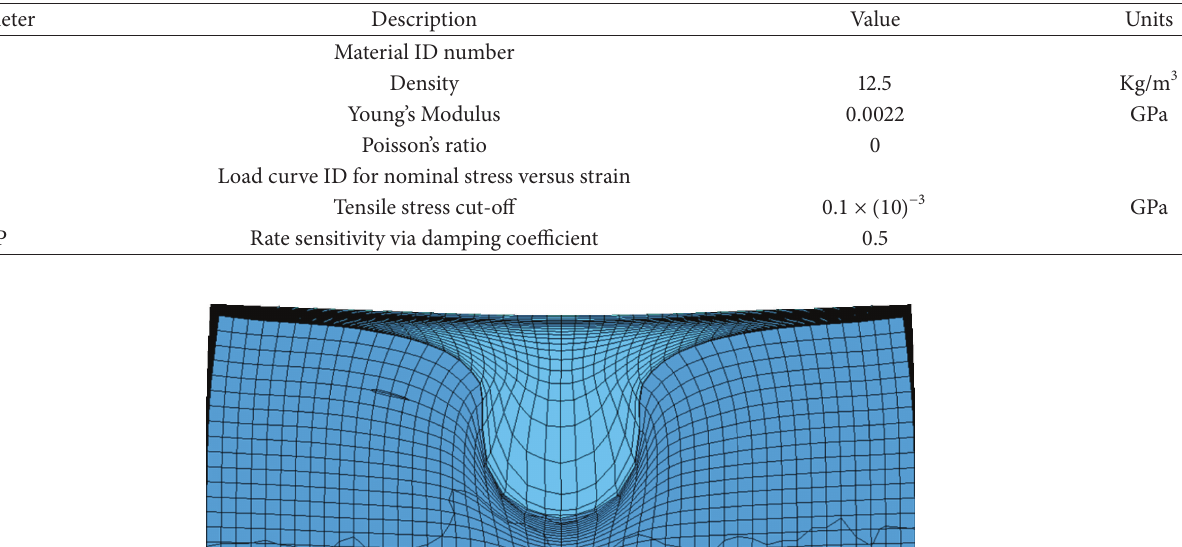
Table 3: Input card for MAT CRUSHABLE FOAM.